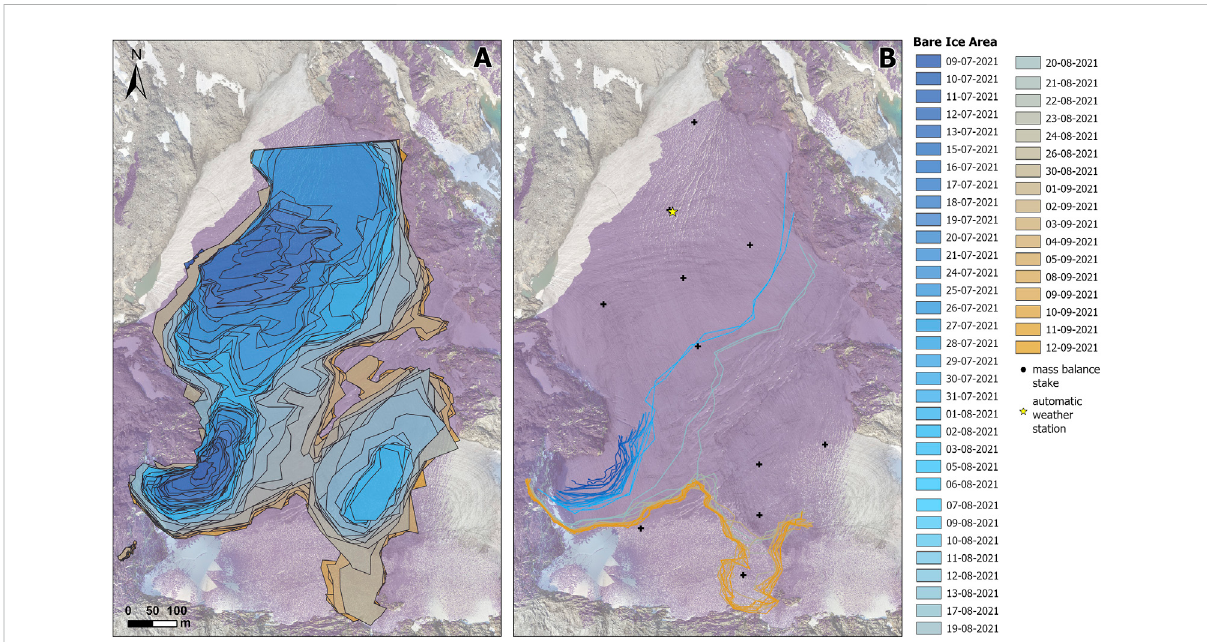
FIGURE 2 Evolution of (A) bare-ice area derived from manually-delineated polygons in PyTrx and (B) snowline derived from manually-delineated lines in PyTrxonQASduringthe2021summermeltseason.Notebareiceareasandsnowlinesupuntil12thSeptember2021areshown,whichisthelastdate before several light snowfall events partially cover the bare ice. Melting then continues until 28th October (Figure 4). Camera viewshed is shown in purple. Locations of mass balance stakes and the AWS are shown in Panel (B)